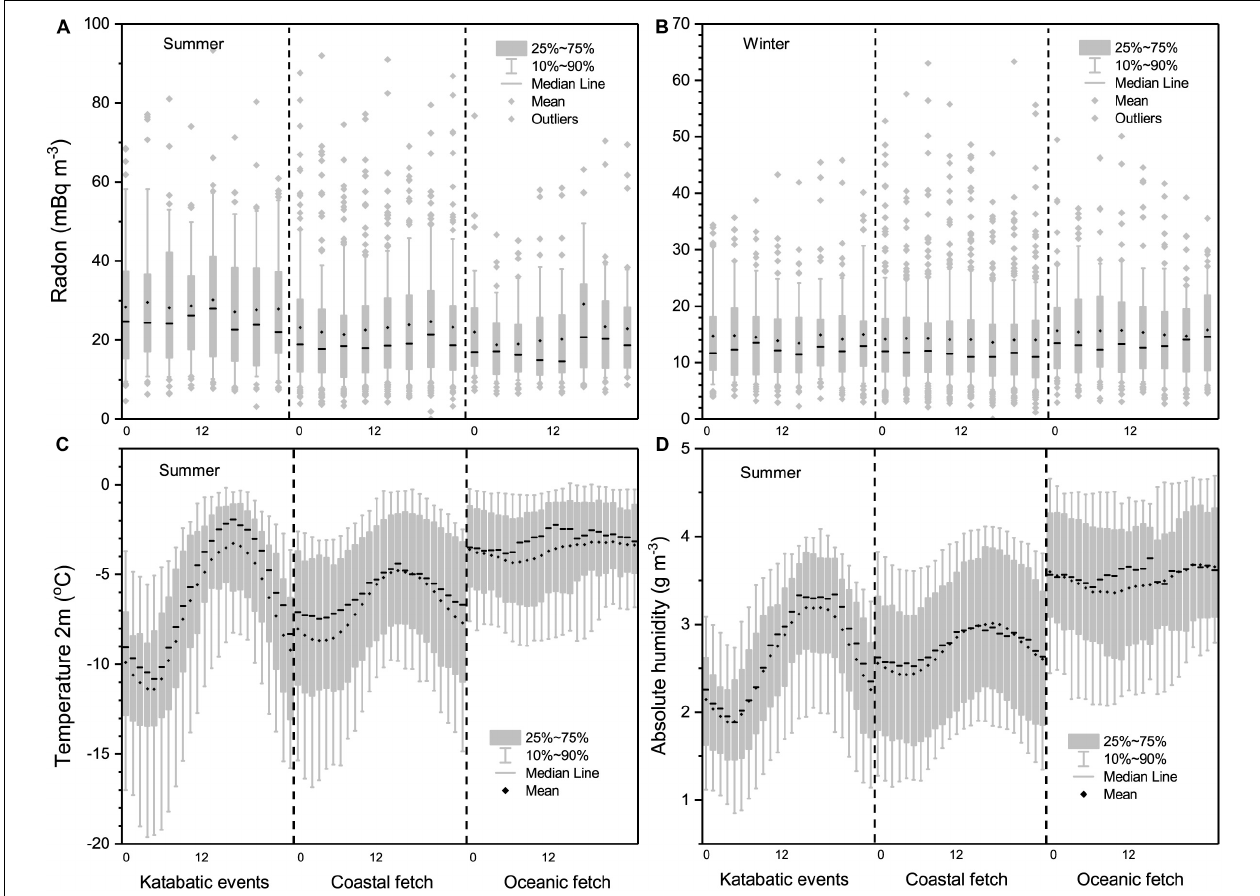
FIGURE 12 | (A,B) Comparison of summer and winter diurnal composite radon distributions for katabatic, coastal and oceanic fetch, and (C,D) diurnal composite summer temperature and absolute humidity values for katabatic, coastal and oceanic fetch at NM in 2010 and 2011. Refer to key for distribution box-plot